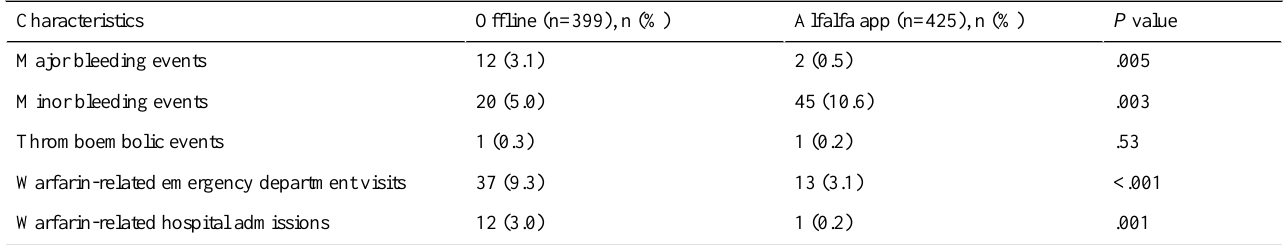
Table 3. Adverse